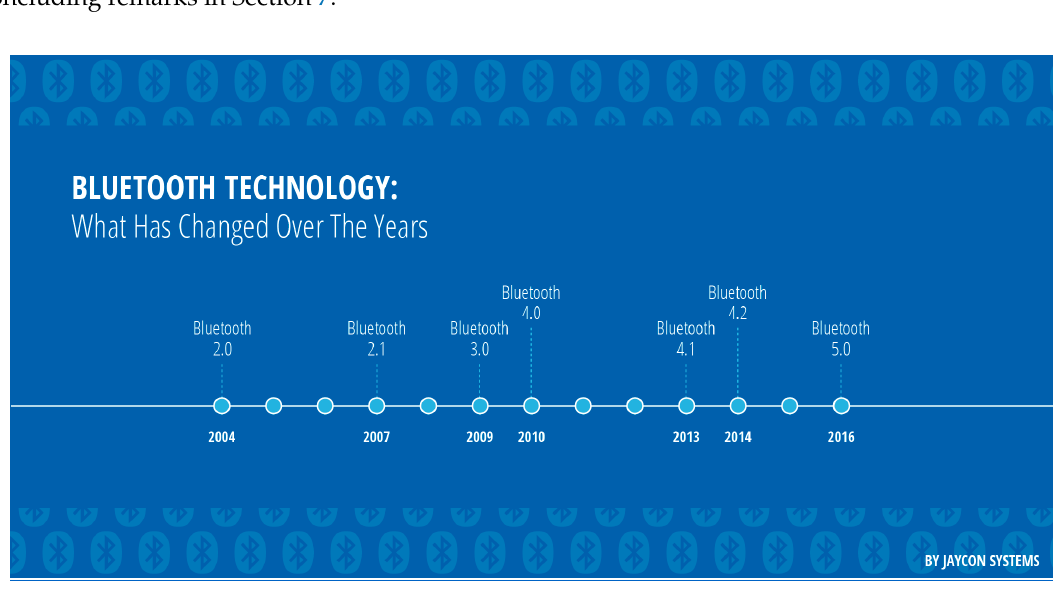
Figure 3. Evolution of Bluetooth technology (2004–16) [4].